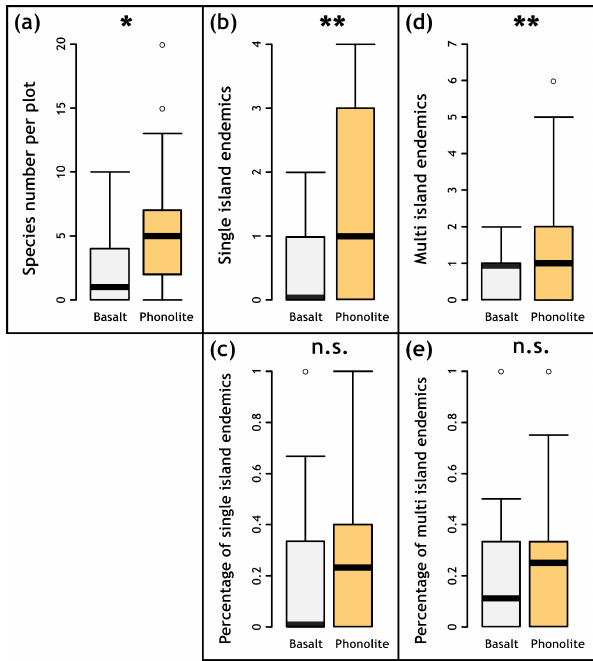
Figure 3. Perennial species per 2 × 2 m plot for basaltic ( n = 60) and phonolite substrates ( n = 60). (a) The number of species per phonolite plot is significantly larger than for basaltic plots. (b) Phonolites have significantly more SIEs and (d) MIEs. How- ever, the numbers of endemic species relative to the total number of species do not differ significantly between substrates (c, e) . All anal- yses were conducted with Pearson’s Chi-squared test (a, b, c) and the Mann–Whitney U test (c, e) .